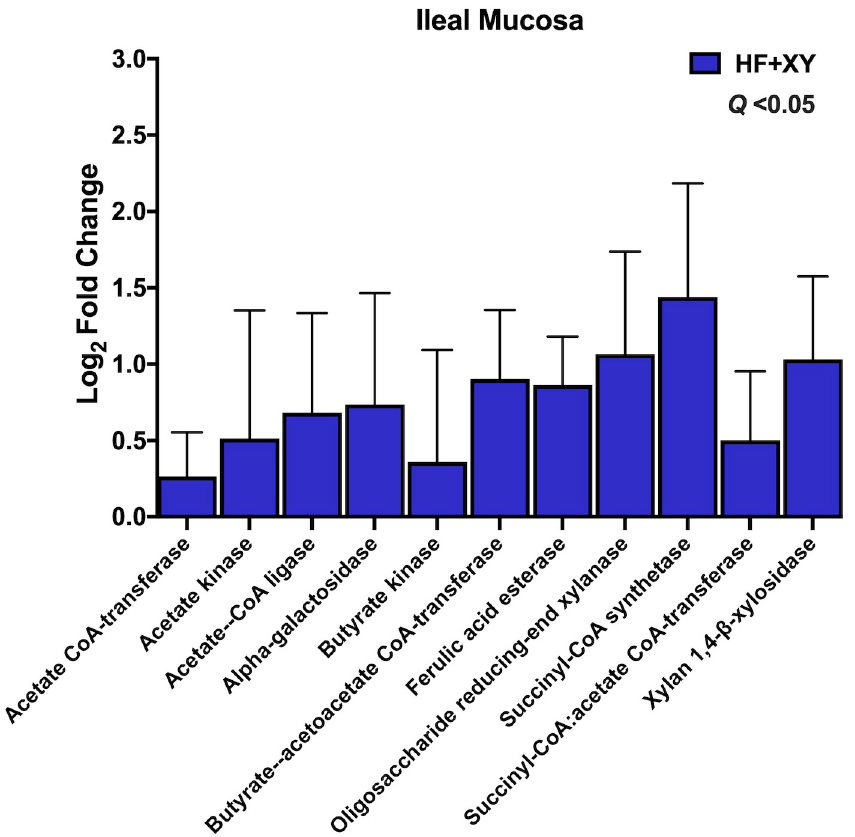
Fig 9. The log 2 -fold change between HF vs. HF+XY for the PICRUST2 predicted gene counts for enzymes associated with bacterial arabinoxylan degradation, xylose metabolism, or short chain fatty acid metabolism in the ileal mucosa that tended or significantly